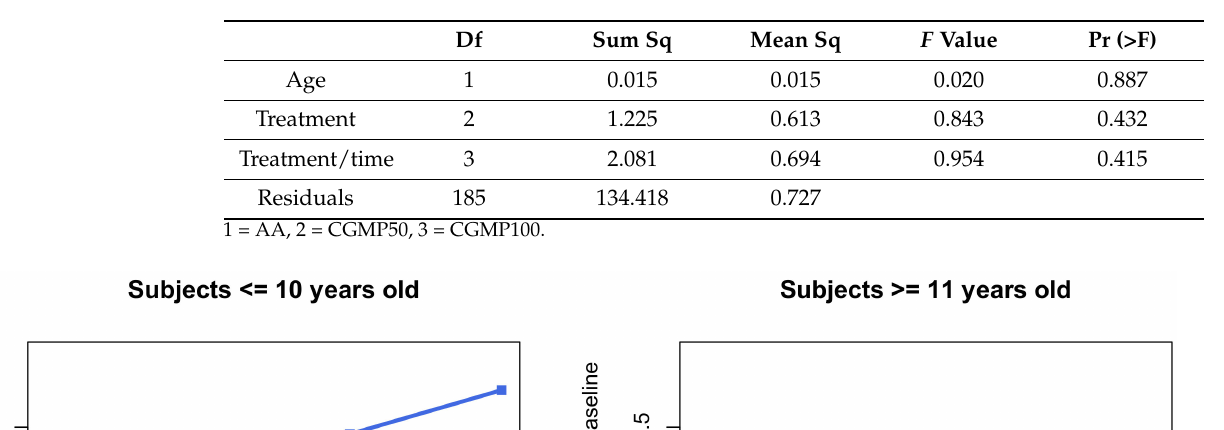
Table 4. ANOVA regression model showing values for age, treatment (AA, CGMP50, CGMP100) and treatment/time.